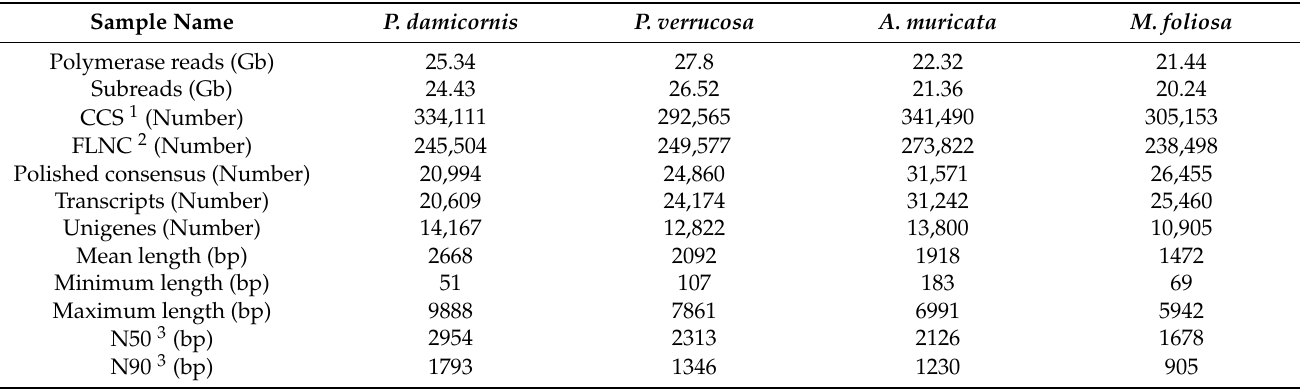
Table 2. Statistics of PacBio Iso-seq